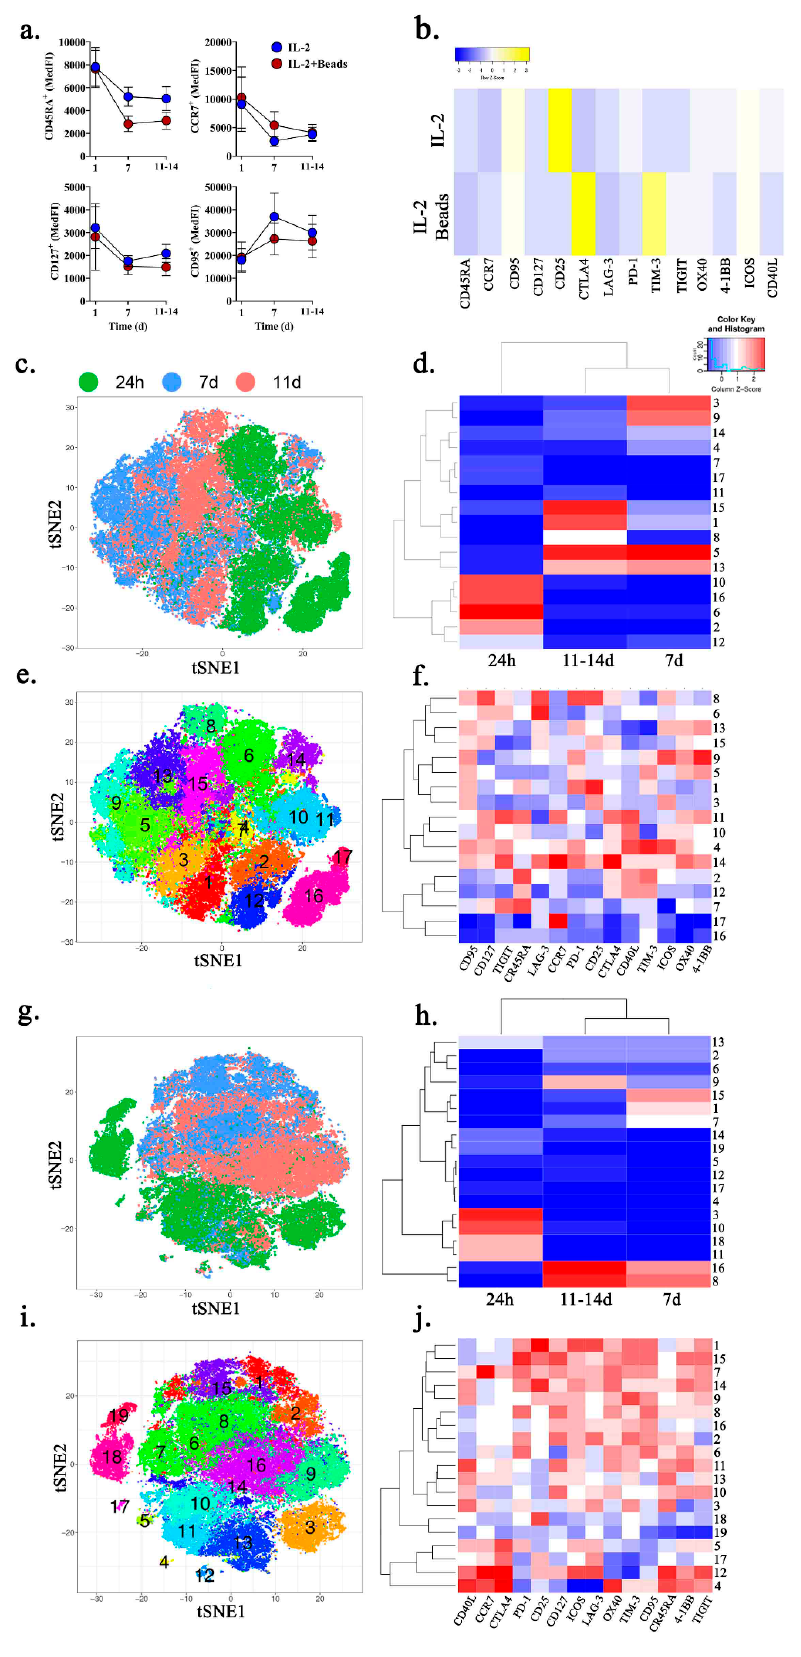
Figure 3. Ex vivo culture promotes terminal di ff erentiation of CD8 + T cells from MPEs. CD8 + T